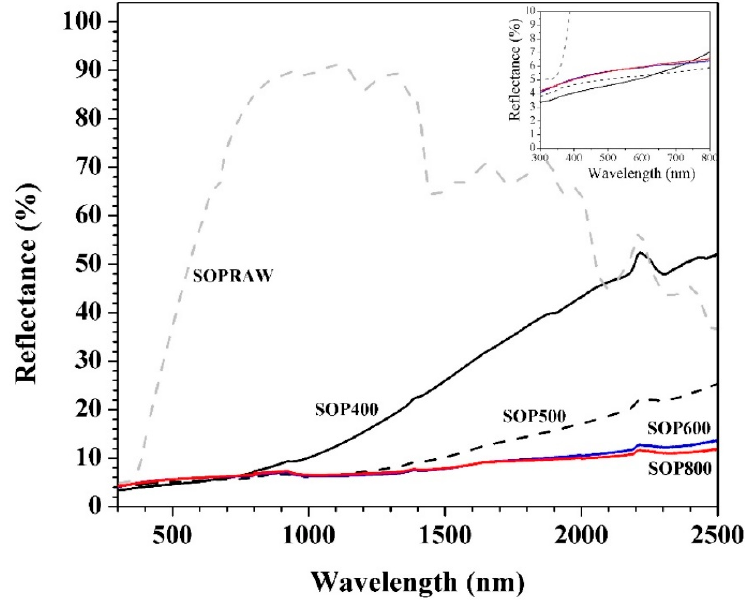
Figure 9. UV − VIS − NIR diffuse reflectance of SOPRAW and biochars.